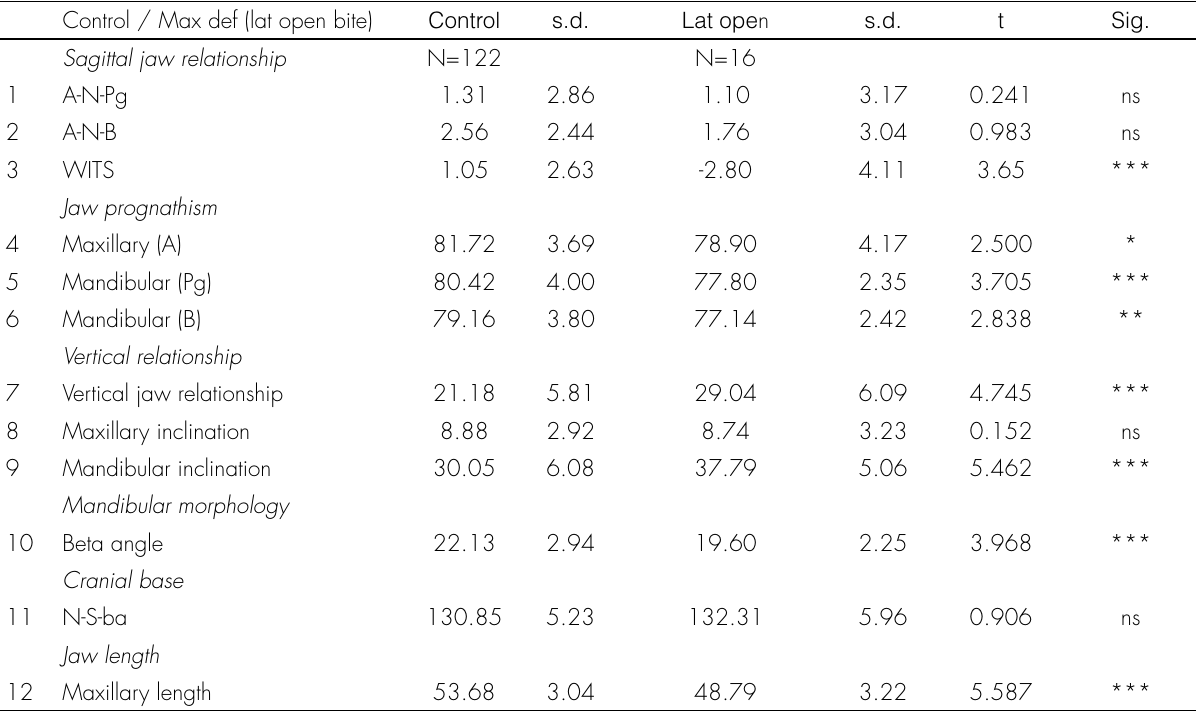
Table IIIg. Comparison between groups of the experimental material and the control material in terms of lateral open bite